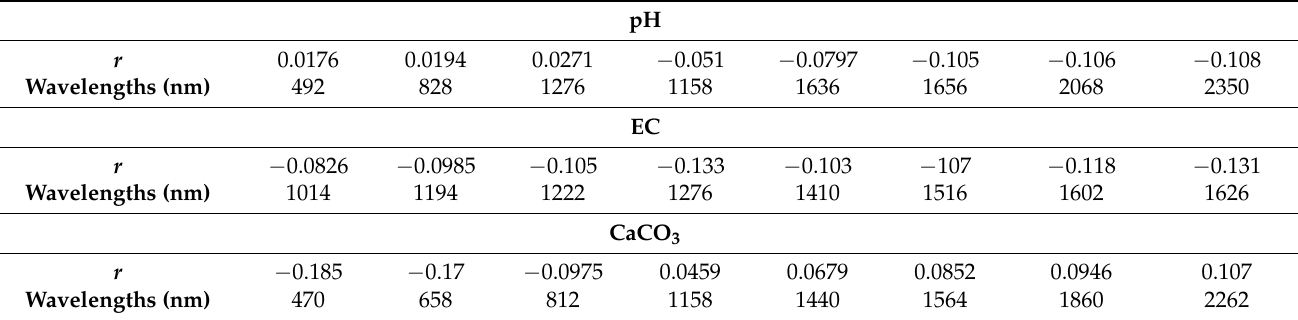
Figure 4. Correlation between spectra and soil parameter. Table 4. The most significantly correlated bands with each soil parameter.